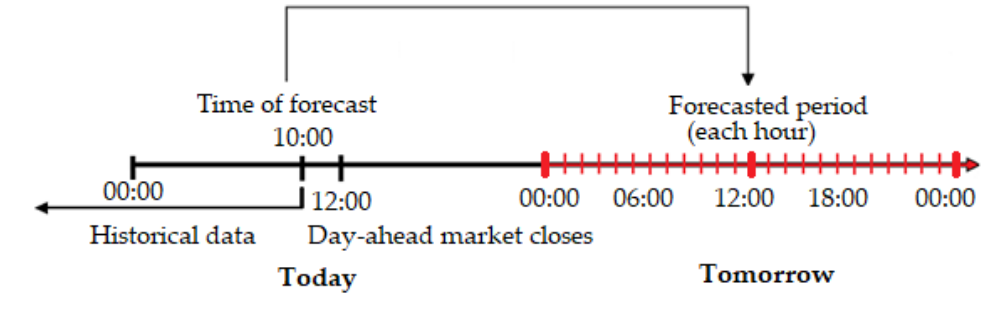
Figure 4. Day-ahead forecast timeline.